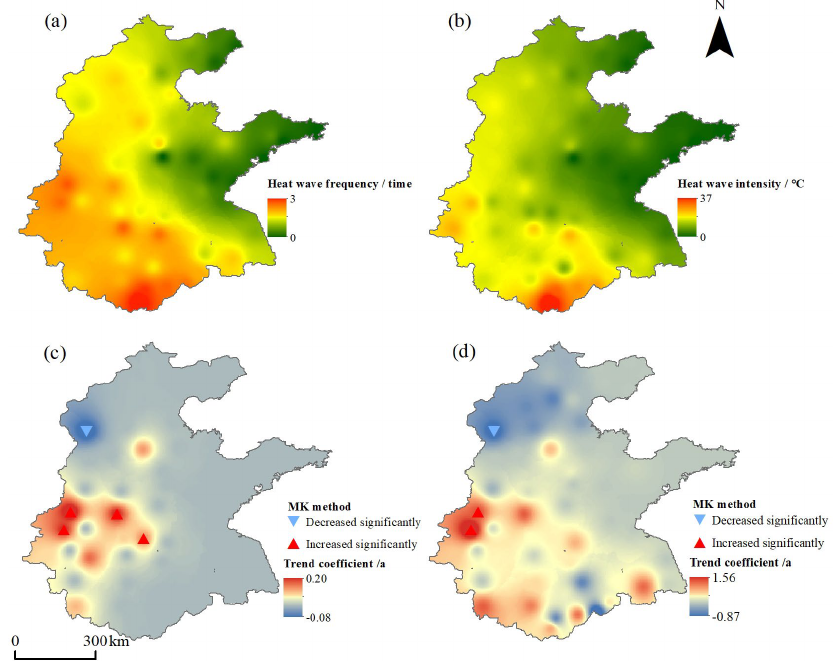
Figure 5. Changes in spatial distribution ( a , b ) and change trends ( c , d ) of the frequency and intensity of high-temperature heat waves on the North China Plain in summer from 2000 to 2018. 3.3. Spatial and Temporal Variation Characteristics of Drought-Induced Risk In summer, the drought-induced risk in the North China Plain was generally low (Figure 6), with an average of 0.11 for many years. The risk in 2008 was the lowest, at only 0.03; and the risk in 2014 was the highest, at 0.20. From 2000 to 2018, the drought-induced risk showed an insignificant increasing trend (0.01/10 year), of which the decreasing trend ( − 0.14/10 year) was obvious from 2000 to 2008, but showed an increasing trend (0.03/10 year) from 2008 to 2018, with obvious fluctuations.